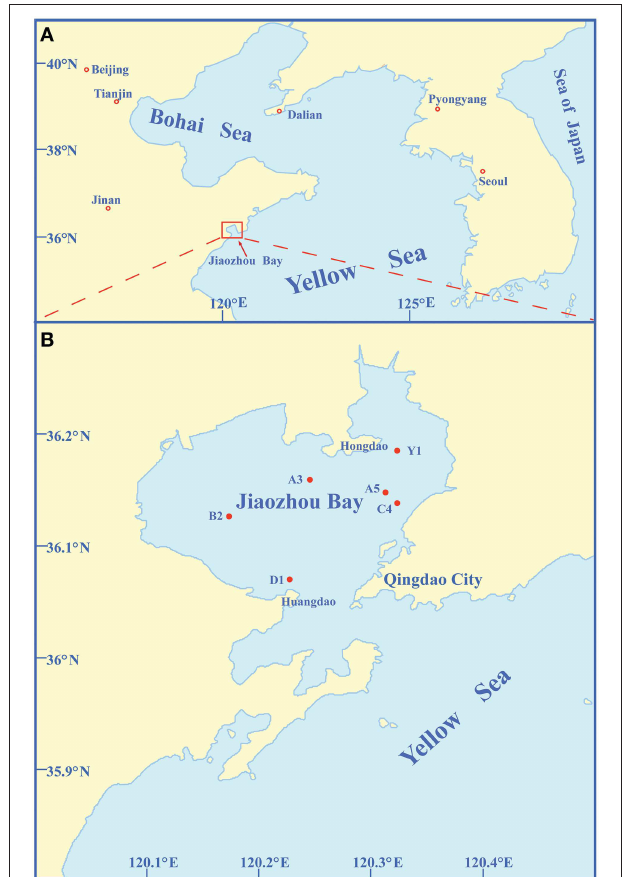
FIGURE 1 | Geographic location of Jiaozhou Bay (A) and sampling stations in Jiaozhou Bay (B).